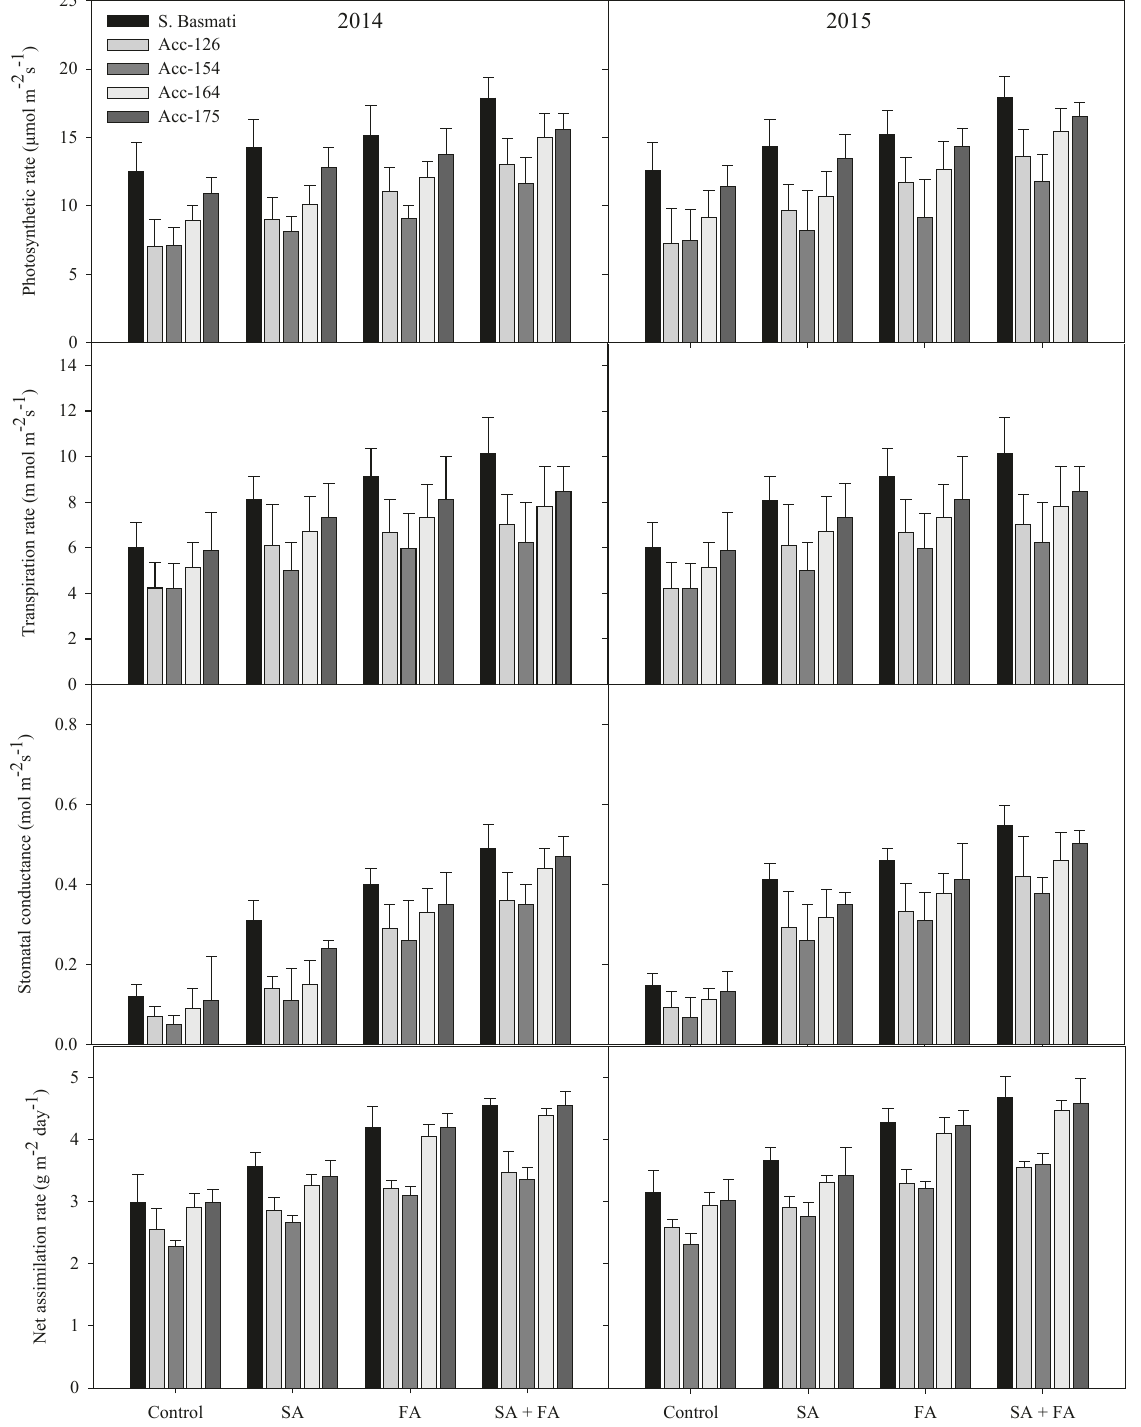
Fig. 1: Effect of Zn fertilization treatments on physiological and growth attributes of rice genotypes. Vertical bars above mean denote the standard error of three replicates.